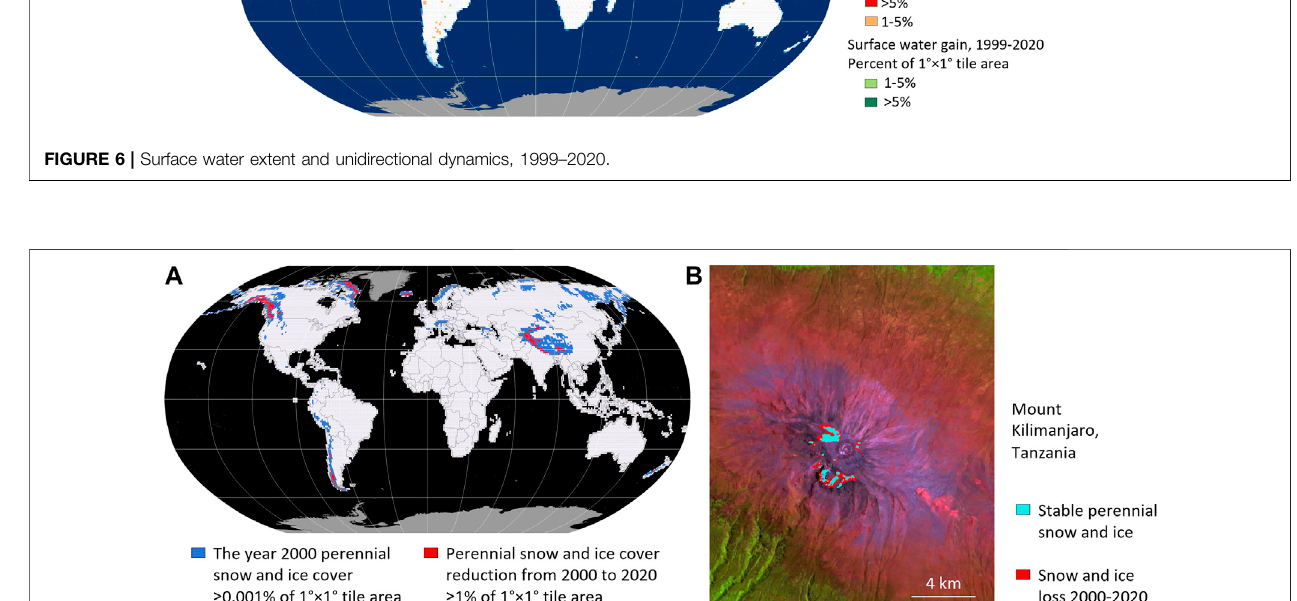
FIGURE 7 | (A) The year 2000 perennial snow and ice extent and its 2000 – 2020 reduction for each 1 × 1 ° grid cell. (B) Mount Kilimanjaro perennial snow and ice reduction, 2000 – 2020.